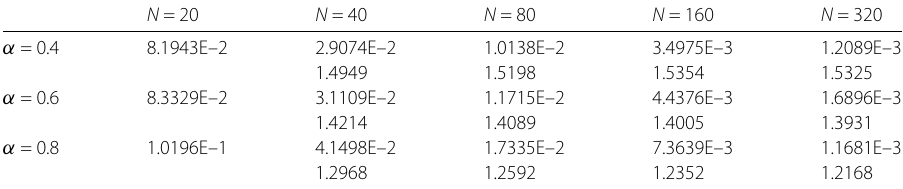
Table 1 E M , N errors and orders of convergence for L1 FEM with r = (2 – α )/ α 1 N = 20 N = 40 N = 80 N = 160 N = 320 α = 0.4